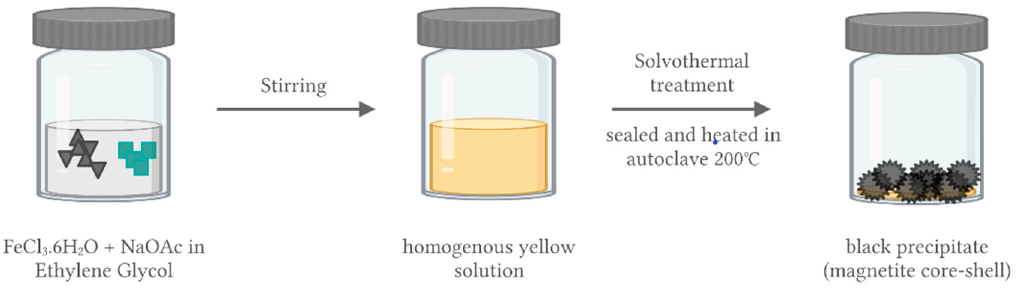
Figure 3. Synthesis of magnetic cores: solvothermal method.